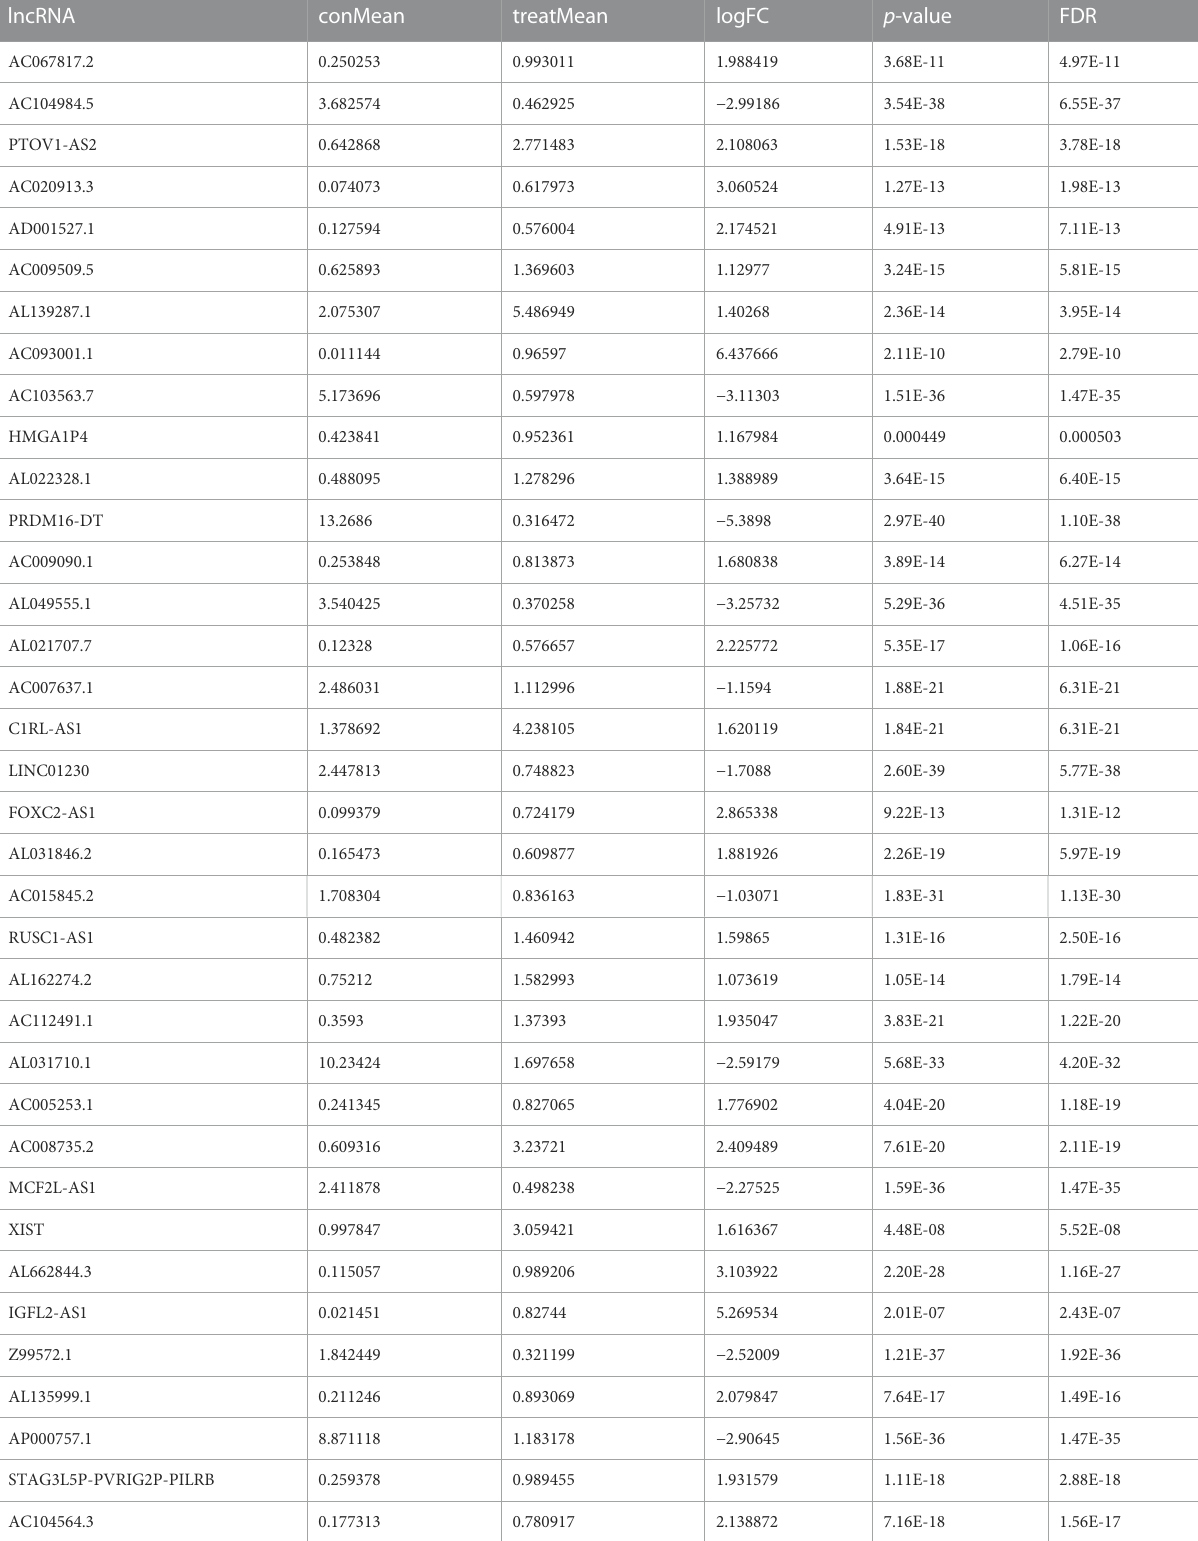
TABLE 1 Lipid metabolism-related lncRNAs acquired posterior to differential expression